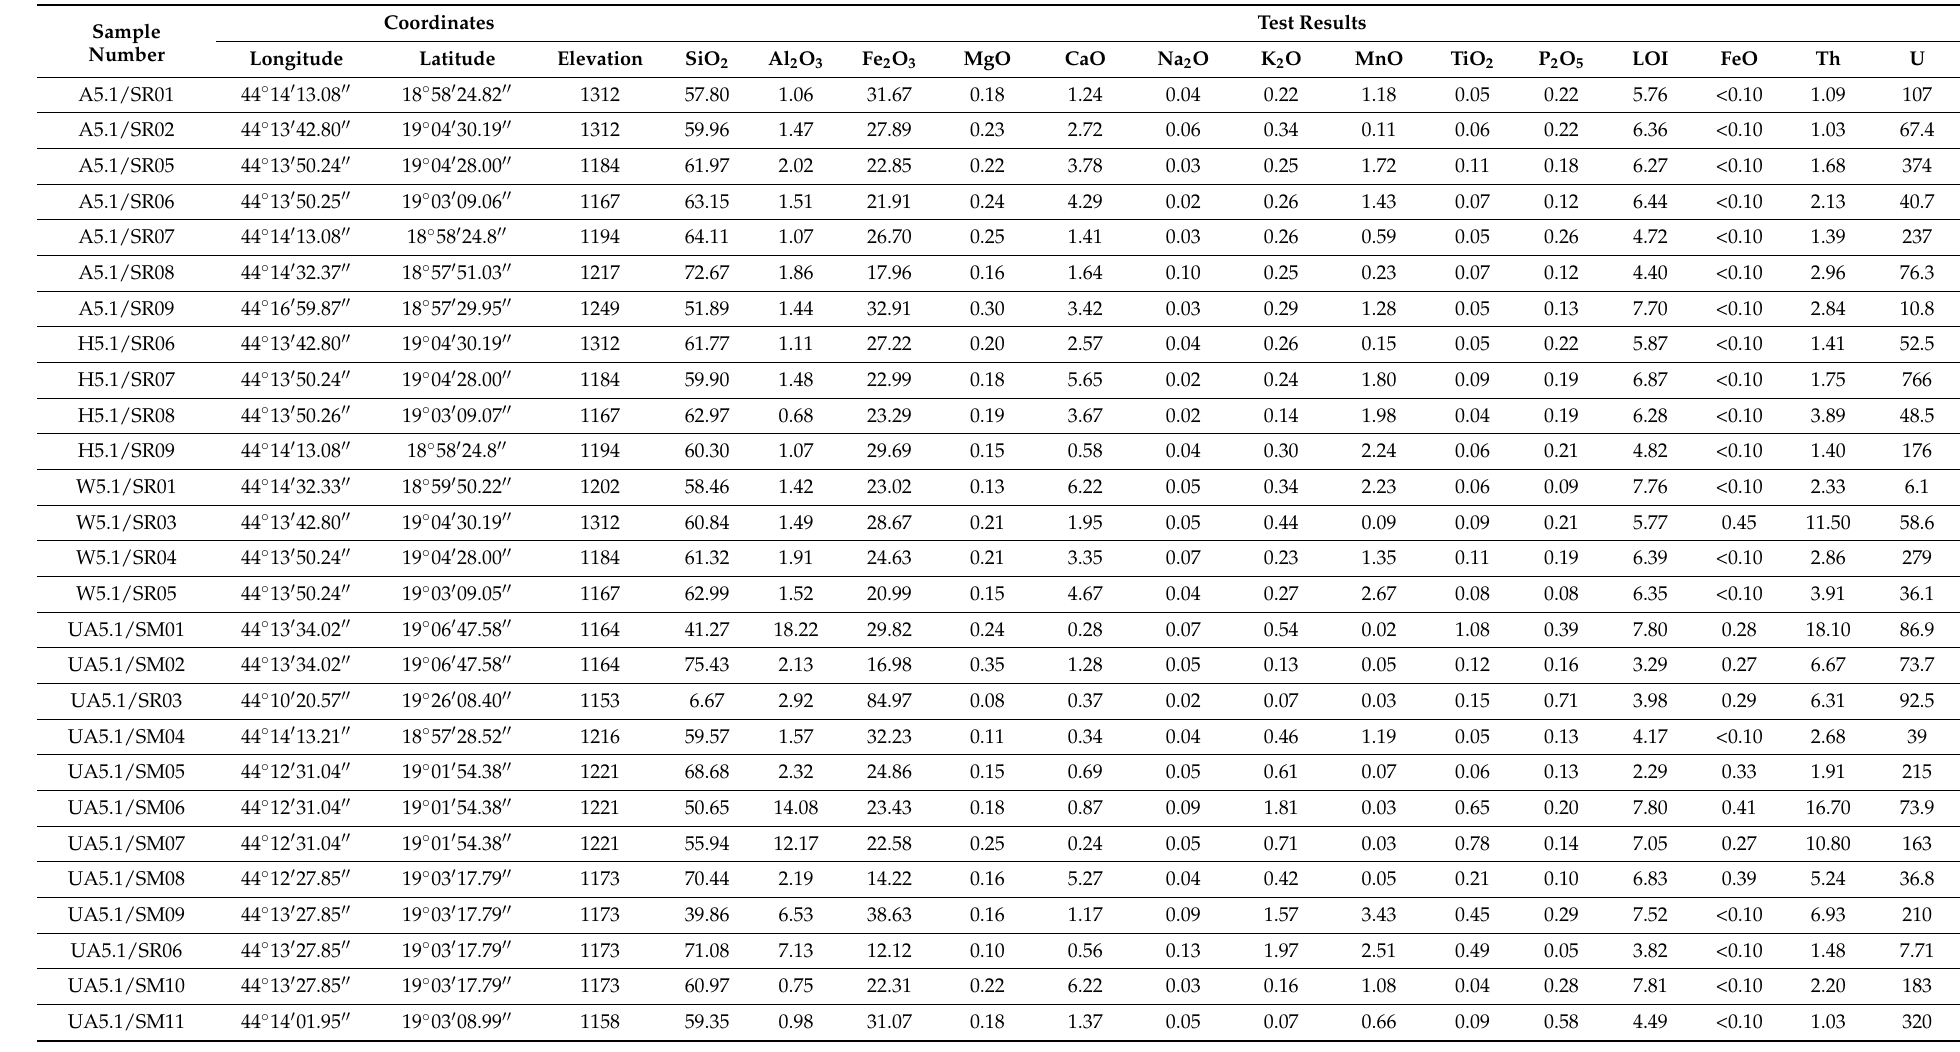
Table 1. Contents of major elements (in wt.%) and U, Th (in ppm) in ferruginous sandstone of Wajid